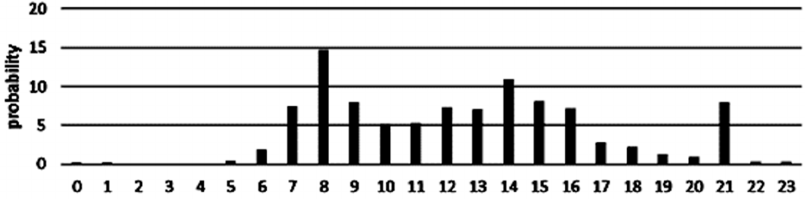
Figure 4. Stochastic charging profile probabilities along a weekday.